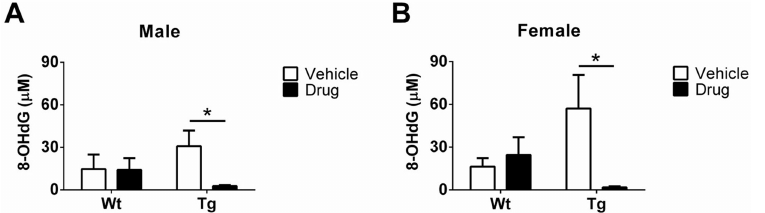
Fig 3. Quantification of urine 8-OHdG levels in different groups by the ELISA kit. (A) 8-OHdG levels of male groups. No difference was found in Wt-males regardlessof treatment, whilea significantdecreaseof 8-OHdG levels was observedin Tg-males treated with the drug compared to their Tg-vehicle littermates. (B) 8-OHdG levels of female groups. Wt-females had no difference regardlessof treatment, however,Tg-females treated with drug showeda significantreduction of 8-OHdG levels. There was no genotypeeffect in both males and females. Treatment effect (vehiclev.s. drug): * P < 0.05.All data are expressed as Mean ± SEM, N = 5 mice/group.